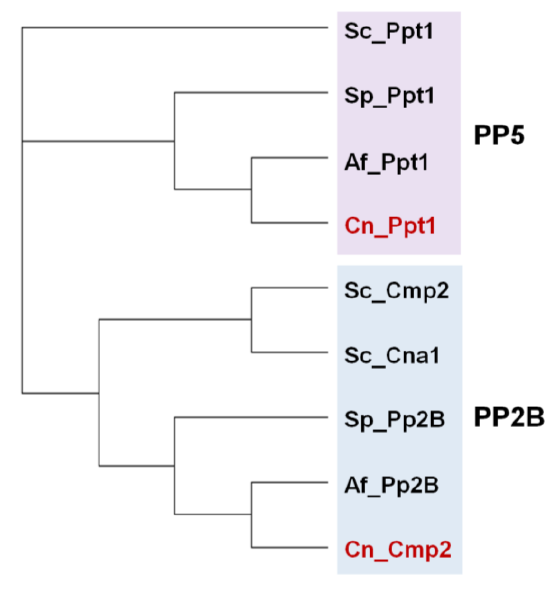
FIGURE 10: Phylogenetic relationship of PP2B and PP5 (Ppt1) phosphatases from various fungal species. Protein sequences correspond to organisms described in Figure 2. The analysis was performed as described in Figure